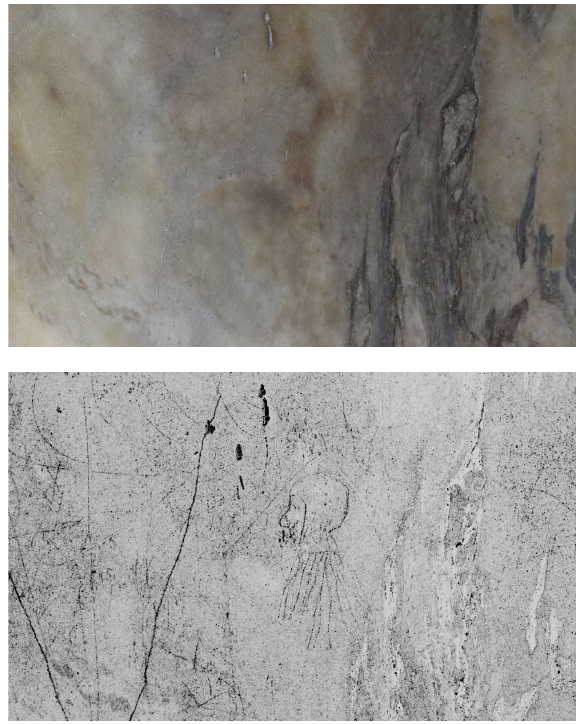
Figure 6. San Marco Basilica, pillar, orthophoto, Doge’s head detail, RGB (top) – change-detection (bottom)